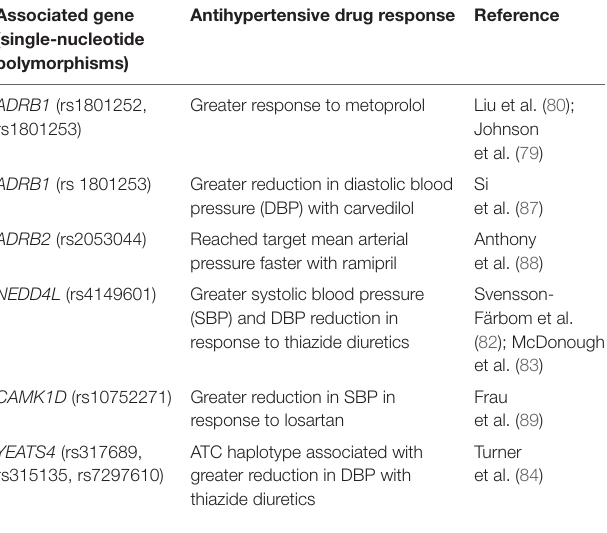
Table 3 | Genes associated with responses to antihypertensive medications [modified from Burrello et al. (14)]. associated gene (single-nucleotide